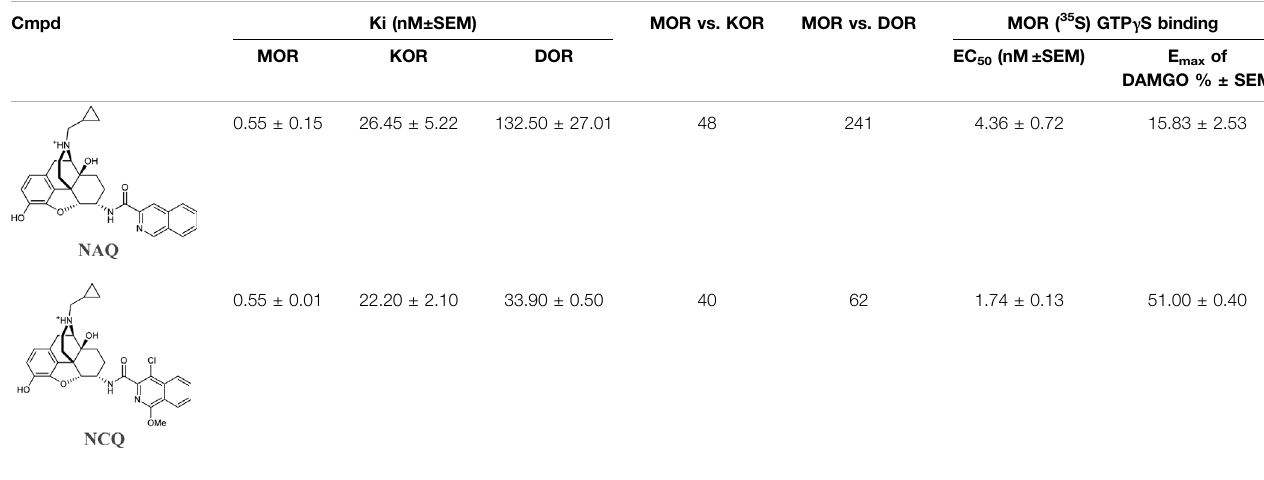
TABLE 8 | Binding af fi nities and functional ef fi cacies of NAQ and NCQ (Wang et al., 2020). Cmpd